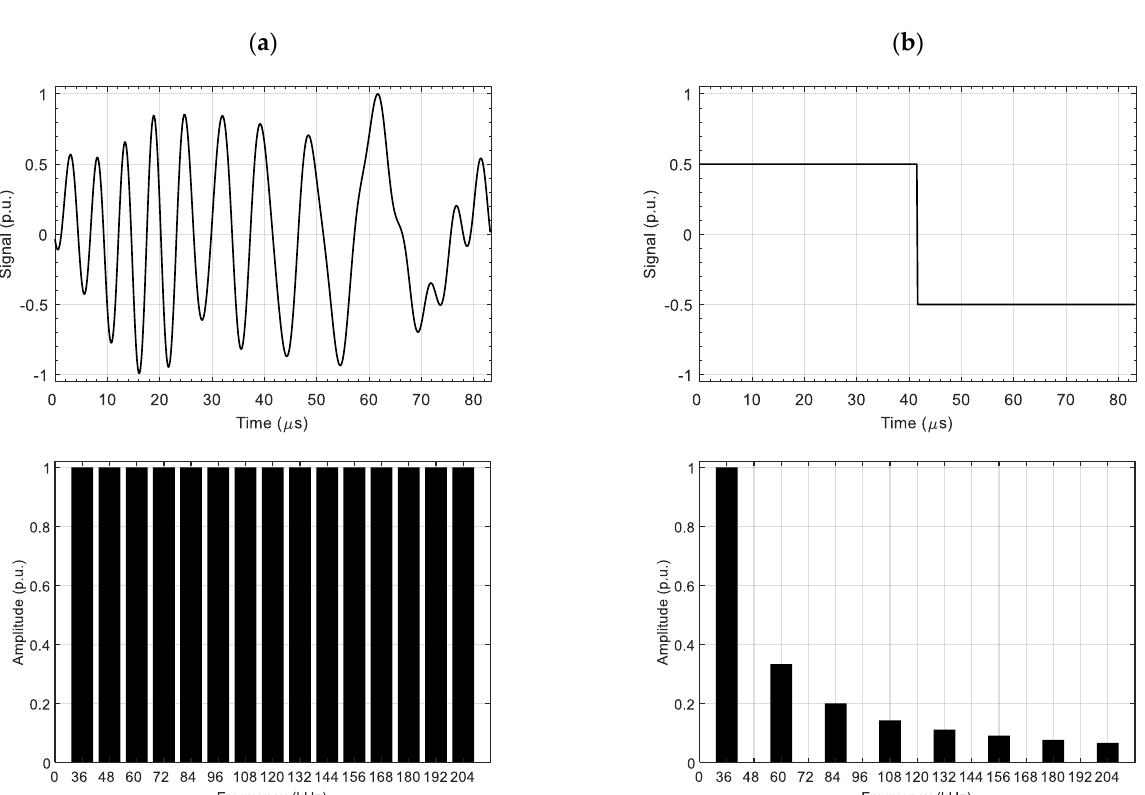
Figure 2. Comparison of the frequency spectrum for PMFES/MFES-ECT ( a ) and PECT ( b ). The signal is at the top and its spectrum (FFT) at the bottom. Signal parameters were selected to obtain the equal amplitude of the first harmonic for both signals.